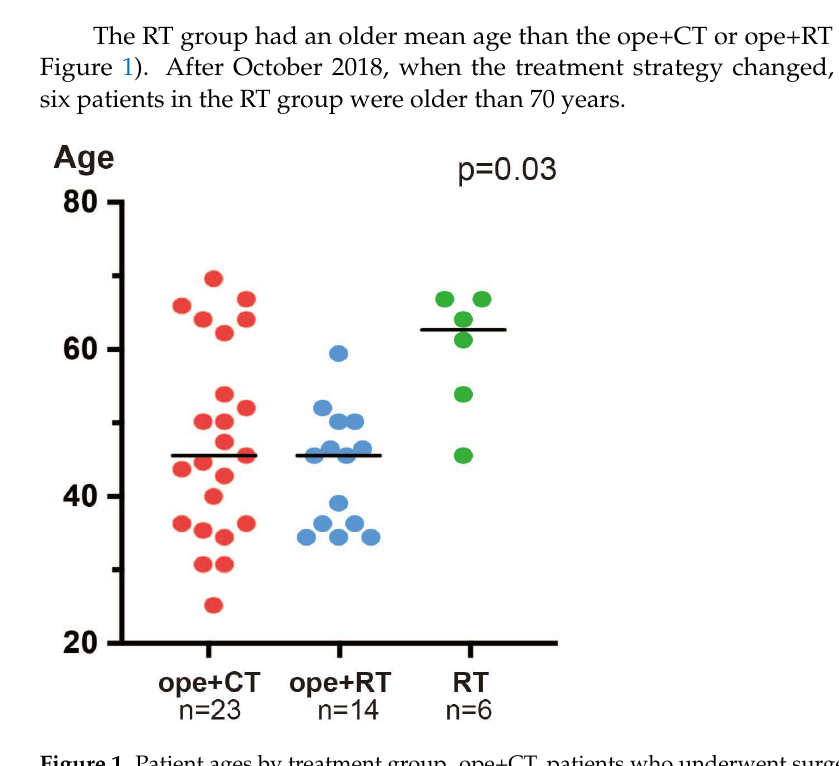
Figure 1. Patient ages by treatment group. ope+CT, patients who underwent surgery and chemother- apy (neoadjuvant or adjuvant); ope+RT, patients who underwent surgery followed by radiotherapy (including concurrent chemoradiotherapy); and RT, patients who underwent radiotherapy (including concurrent chemoradiotherapy). The p -value is based on the Kruskal–Wallis test. Among the stage IIIC1 patients, all those with T1N1 underwent surgery as the main treatment: five in the ope+RT group (surgery followed by CCRT in four patients and surgery followed by CCRT and systemic chemotherapy in one patient) and seven in the